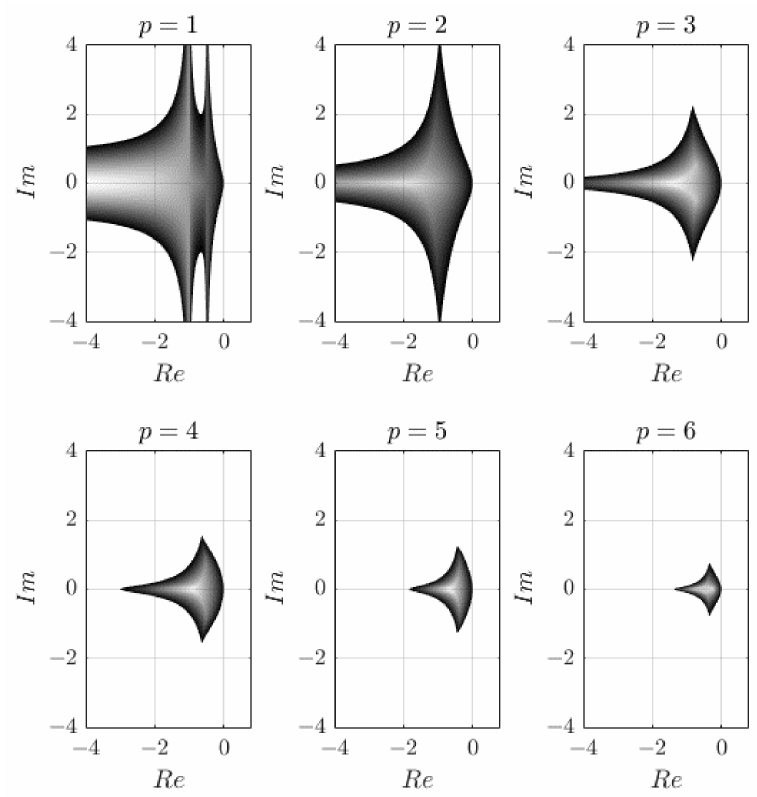
Figure 4. Stability regions of the semi-implicit Adams–Bashforth–Moulton methods with k = 1.